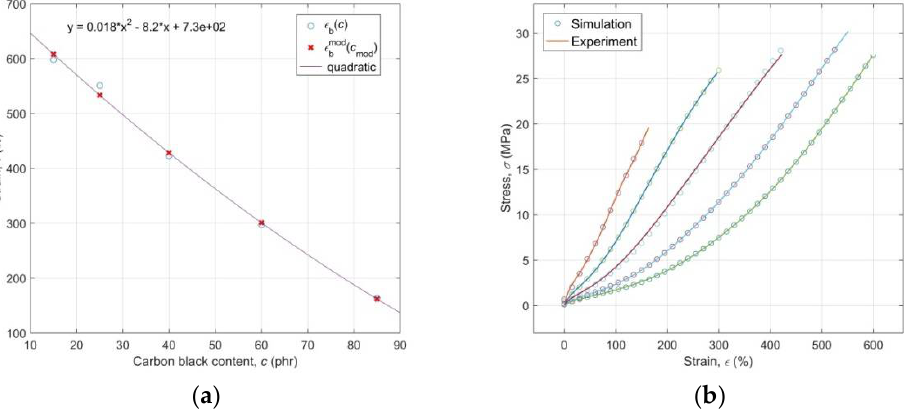
Figure 9. ( a ) Selection of the ε bmod values for simulation of the optimized model with modeled input data; ( b ) Comparison of the experimental stress-strain curves with the curves simulated by a model with modeled input data.